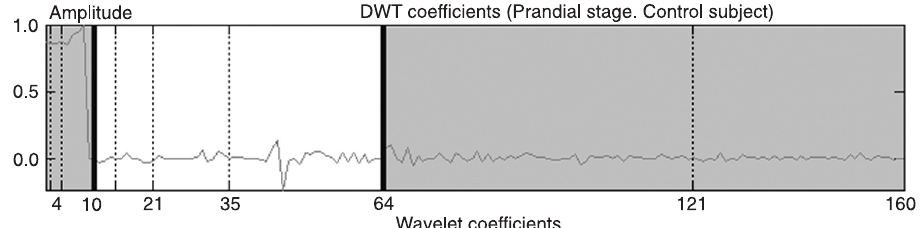
Figure 2. Remaining coefficients after the elimination of the first lower band and the two higher bands (shaded regions) that do not carry information. DWT = discrete wavelet